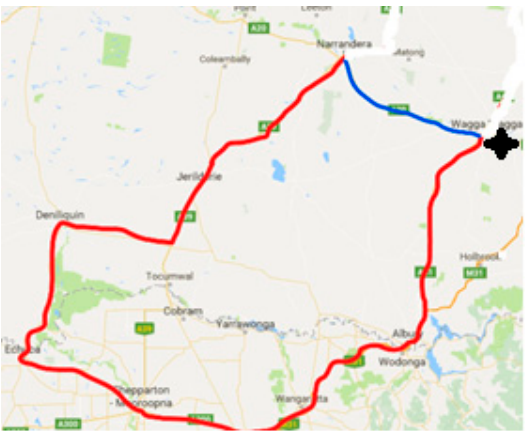
Figure 1. Road transport route travelled by all horses in Part 2 of the study, departing from Wagga Wagga at 18:00 h and returning after 12 h. The route covered a distance of 750 km and proceding in a clockwise direction.